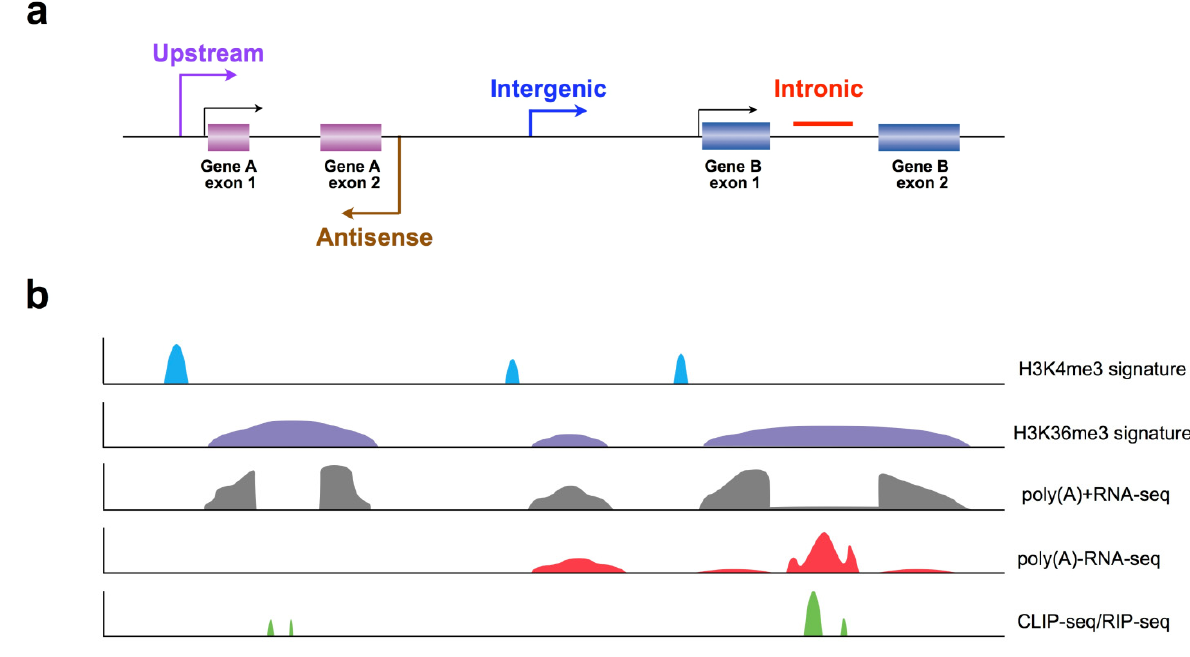
Figure 1. Schematic diagram of long noncoding RNA discovery and function analysis using genome-wide methods. ( a ) Genomic locations for long noncoding RNA (lncRNA) transcription. Boxes shown as annotated genes and exons. Arrows label the direction of transcription. ( b ) Methodology for lncRNA discovery and functional association with proteins. H3K4me3 signature defines transcription initiation. H3K36me3 signature defines transcription elongation. Signals of poly(A)+RNA-seq indicate polyadenylated RNAs (including most annotated mRNAs and lncRNAs). Signals of poly(A)-RNA-seq indicate non-polyadenylated RNAs, including recently identified intronic transcripts. Signals of CLIP-seq/RIP-seq reveal the association of RNA transcripts with RNA binding